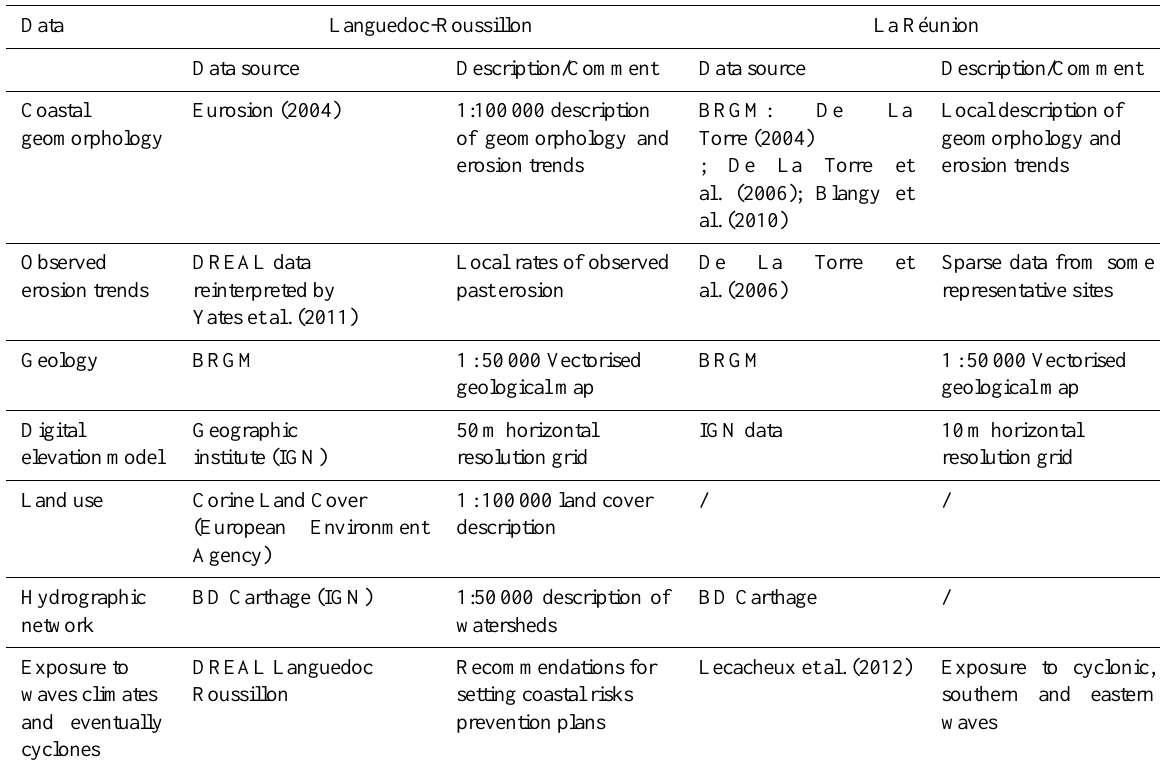
Table 3. Summary of data sources used in this